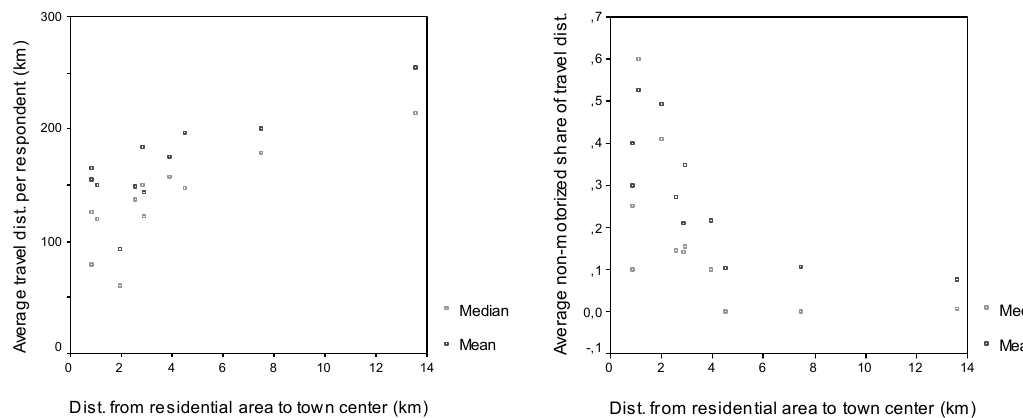
Figure 9. Mean and median values for total travel distance (to the left) and the proportion of distance travelled by non-motorized modes (to the right) among respondents from residential areas located in varying distances from the centre of Frederikshavn. Respondents without a driver(cid:237)s license and respondents using their car for official trips more than 10 times a month have not been included. N = 11 residential areas including 375 counting respondents,